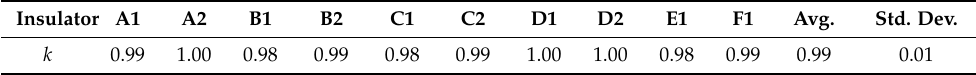
Table 1. Correction factor (k) for the shore A hardness measurements of each available insulator. Insulator